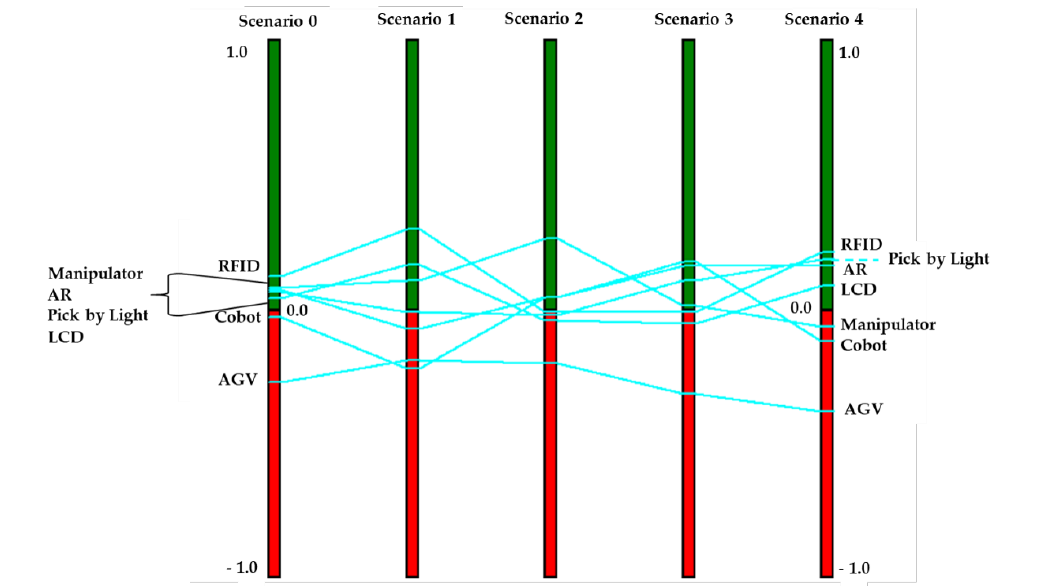
Figure 7. The rank of alternatives for each observed scenario.